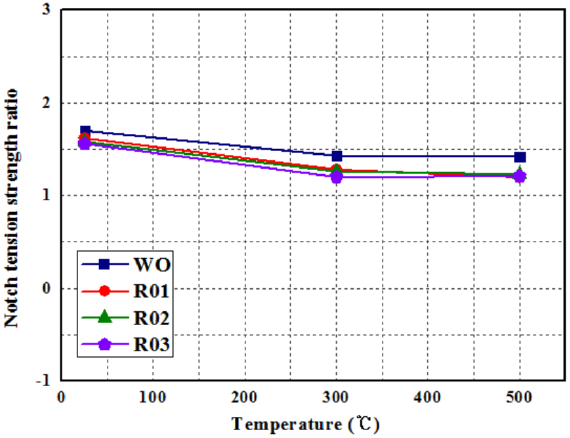
Figure 9. Results of the NSR (notch tension strength ratio).